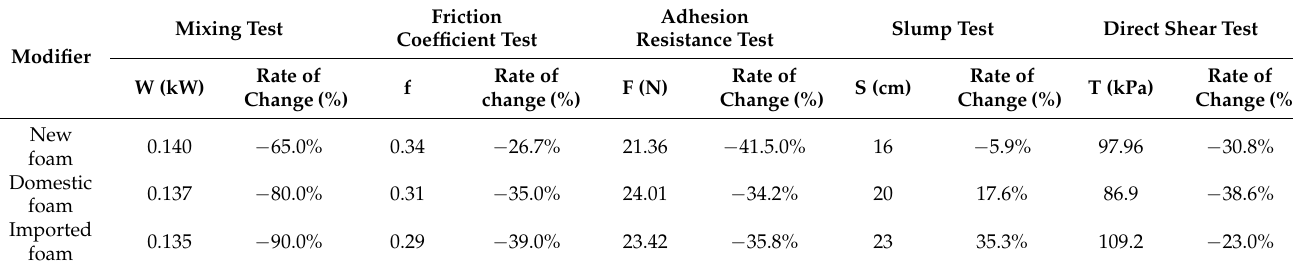
Table 7. Comparison of the effect of improved sand and soil in foam.